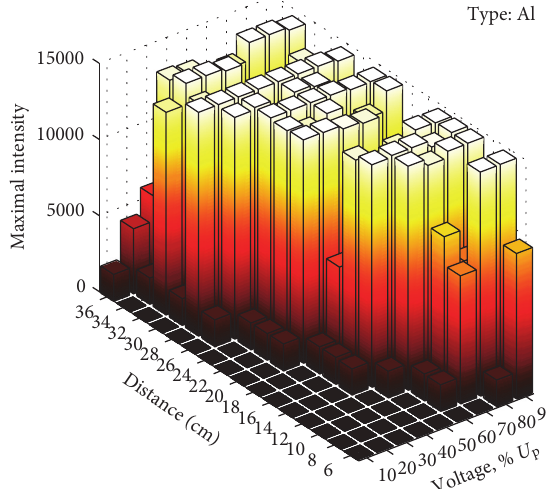
Figure 14: Dependency of voltage and distance on the highest intensity value for the Al line.